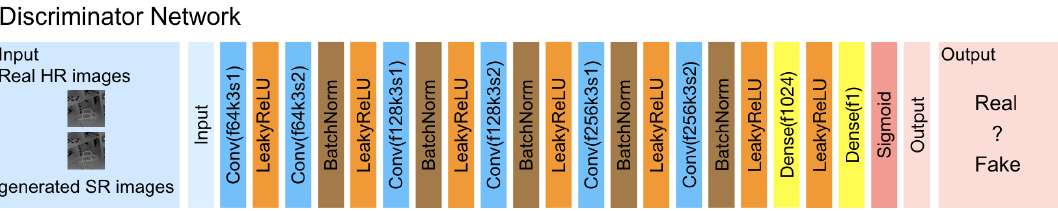
Figure 4. Discriminator network of the proposed generative adversarial network framework for depth map super-resolution with f: the number of feature maps, k: the kernel size, and s: the stride indicated for each convolutional